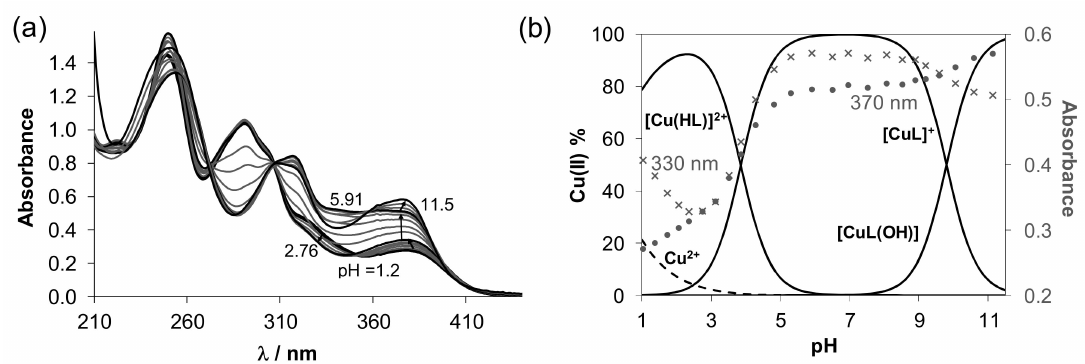
Figure 6. ( a ) UV / Vis absorption spectra recorded for copper(II) complex of [H 2 L H ]Cl ( 1 ) at various pH values, and ( b ) its concentration distribution curves plotted together with the absorbance changes at 330 ( × ) and 370 nm ( • ) ( c complex = 50 µ M; I = 0.1 M (KCl); t = 25 ◦